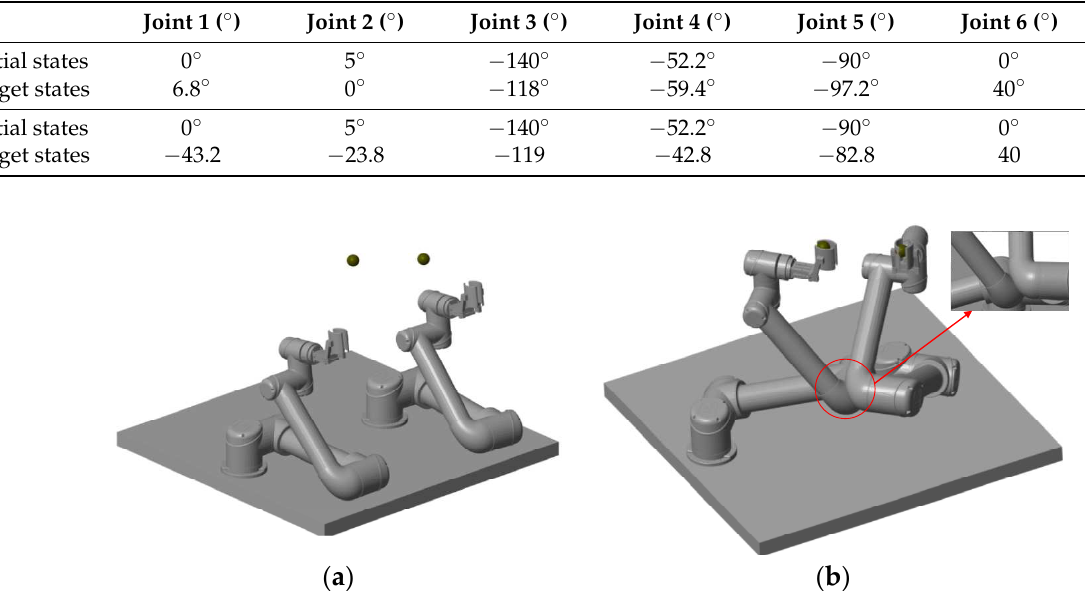
Figure 17. Two-arm picking plan in the collision area. ( a ) No collision detection. ( b ) Collision location.